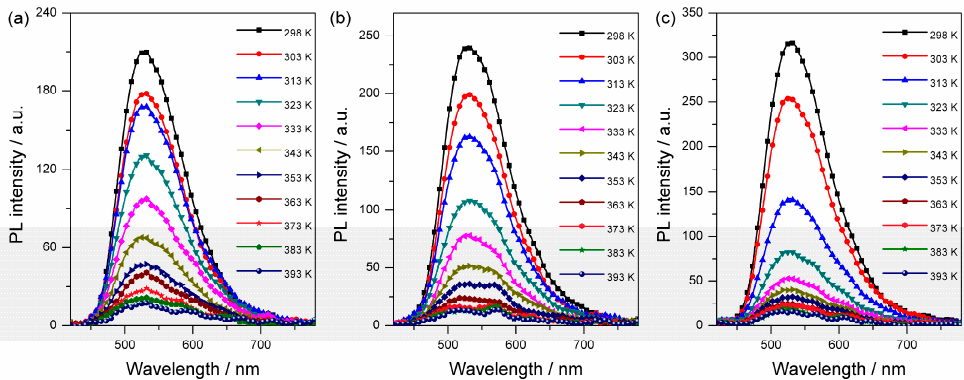
Figure 5. PL spectra of ( a ) Alq 3 (pure), ( b ) Alq 3 (Ag NPs) and ( c ) Alq 3 (Ag NWs) under different temperatures from 298 to 393 K.